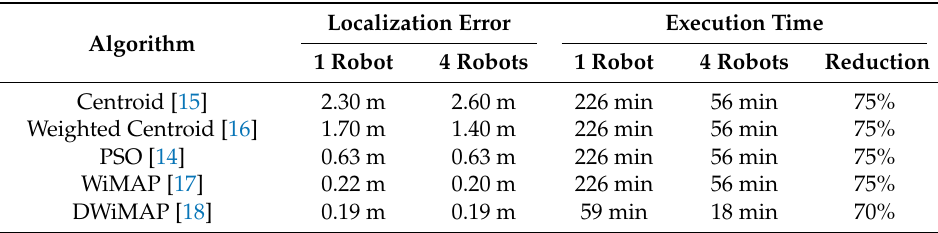
Table 3. A comparison of access point localization